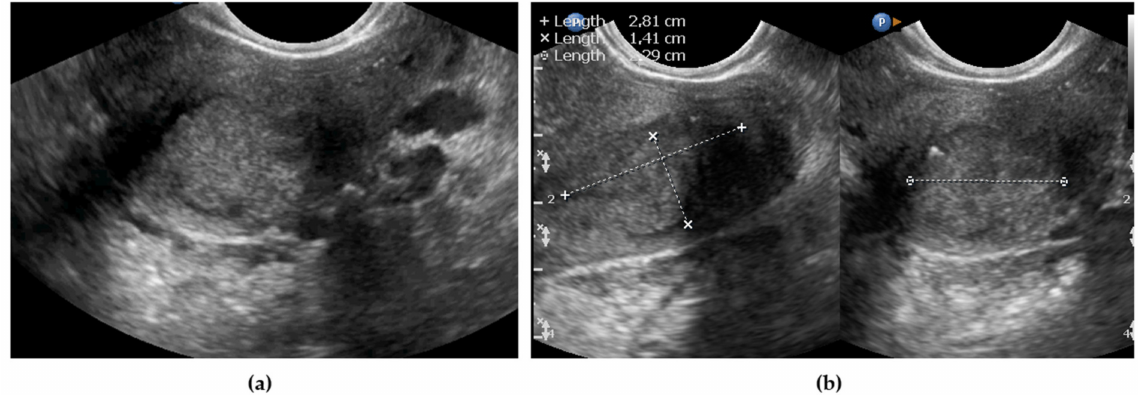
Figure 2. Cervical cancer primary tumor imaged using ultrasonography: ( a ) delineation of the tumor; ( b ) tumor measure- ments (lines indicate calipers on the tumor).